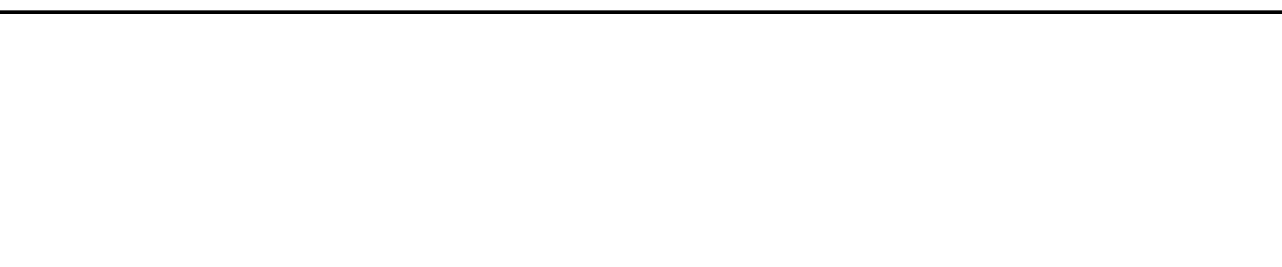
Figure 2: Required Process and Forms for Data